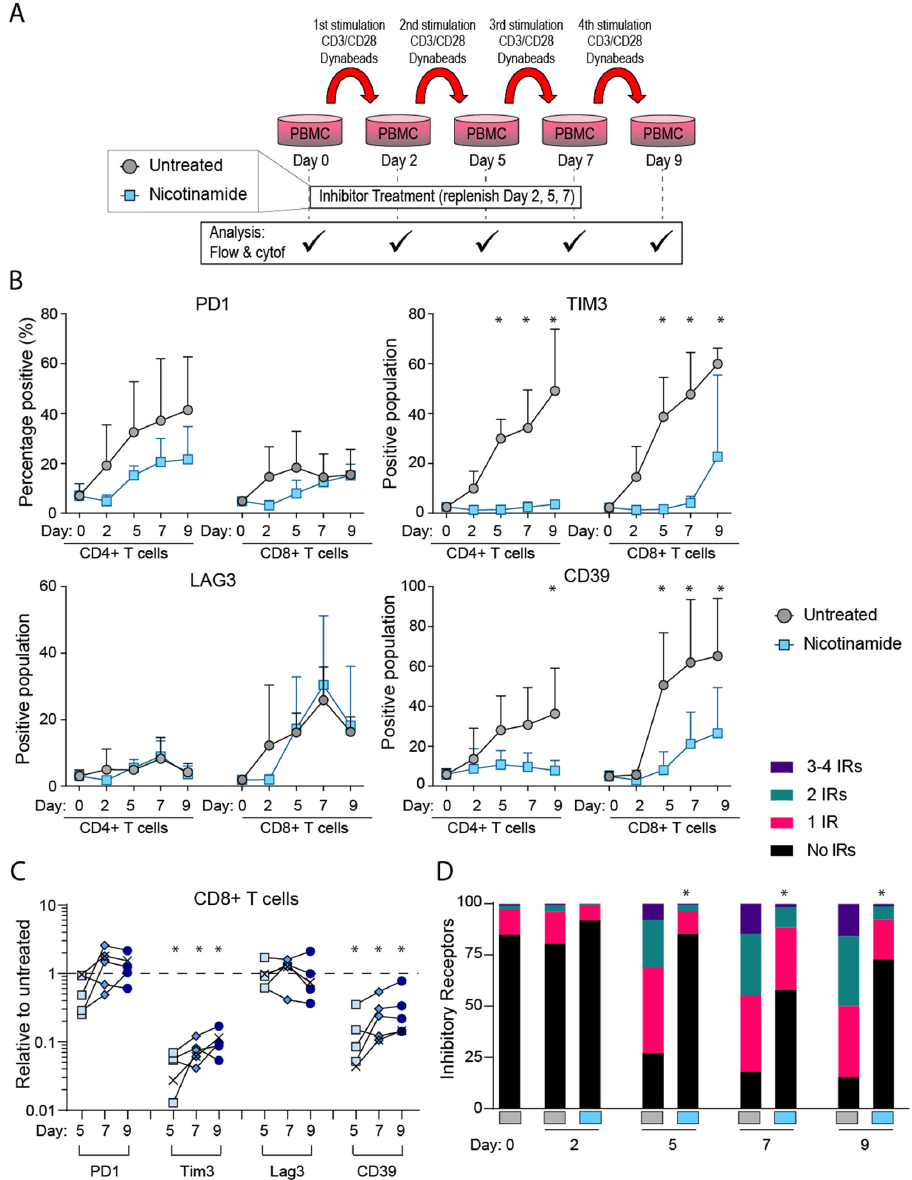
Figure 1. Expression of IRs in vitro in the presence of NAM. NAM reduced expression of TIM3 and CD39. ( A ) Schematic showing experimental set up. ( B ) Time course shown for average across four flow cytometry experiments, with error bars indicating standard deviation, and statistical significance between treated and untreated indicated by * as determined using the Holm-Sidak method ( α = 0.05). Additional statistics performed on ( C ) combined data when compared to untreated only for each time point, on days five to nine across n = 5 in vitro stimulation experiments, Mann-Whitney test ( p < 0.05 indicated by *). ( D ) Cumulative IR expression of total CD8+ T cells as scored for representative experiment shown in 1A, chi-squared analysis (* p < 0.05). Data points marked in ( C ) as ‘X’ were obtained from mass cytometry analysis, with remainder from flow